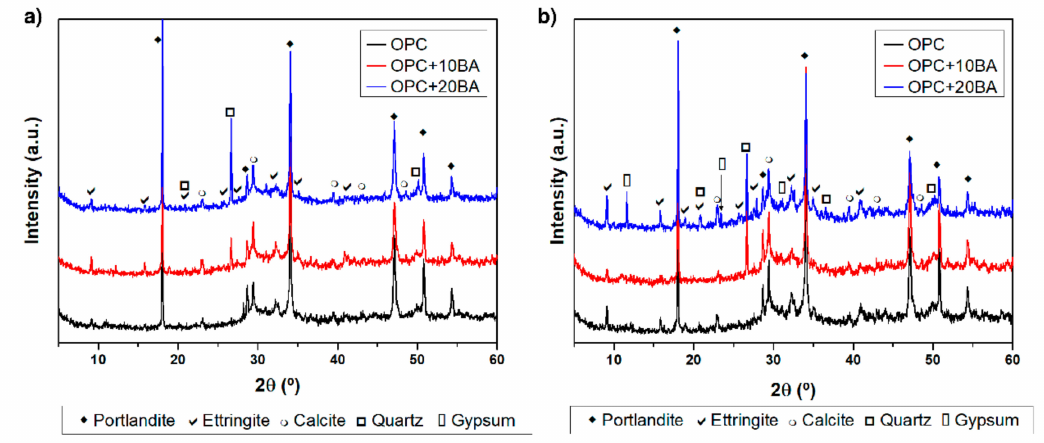
Figure 5. XRD patterns for pastes of ordinary Portland cement (OPC), OPC + 10 bottom ash (BA), and OPC + 20 BA soaked for 180 days in ( a ) water or ( b ) a 0.3 M Na 2 SO 4 solution (from the bottom to the top: OPC, OPC + 10 BA, and OPC + 20 BA).